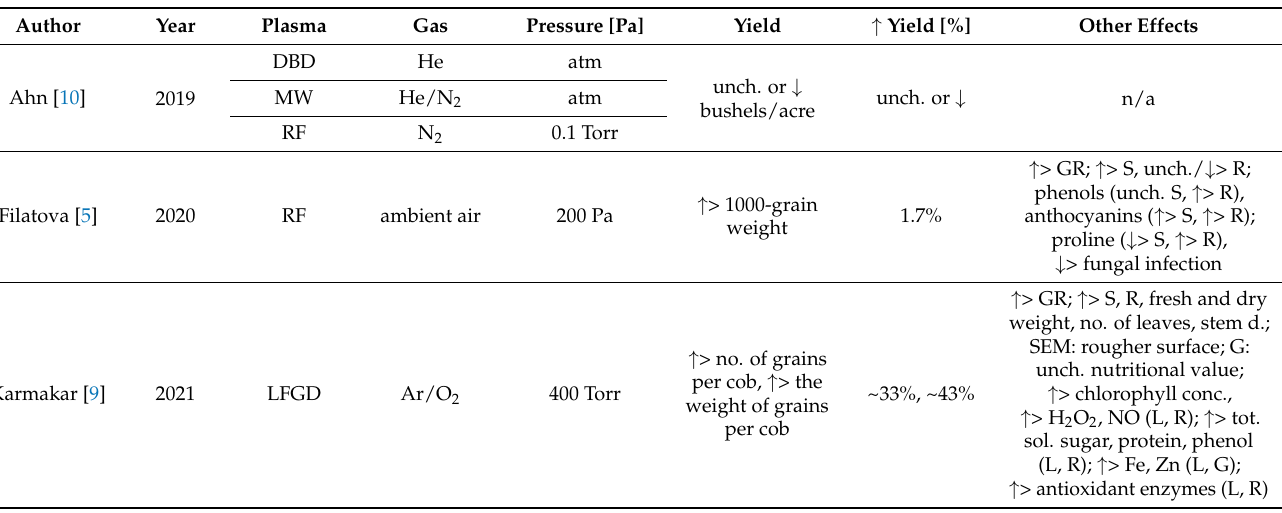
Table 1. An overview of publications regarding the effects of plasma treatment on maize